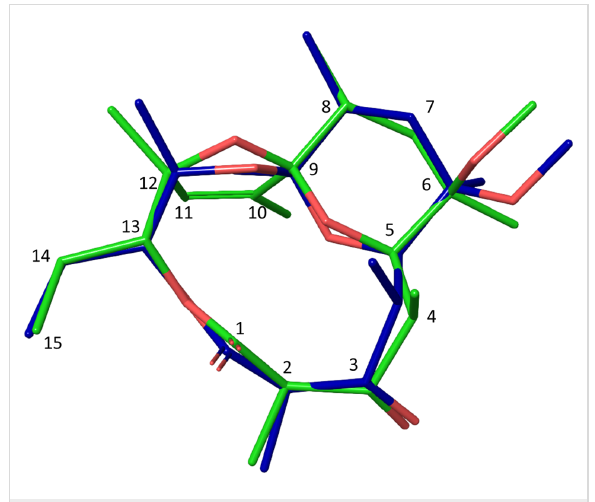
Figure 7: Overlay of the computed structures of 3 (green) and 4